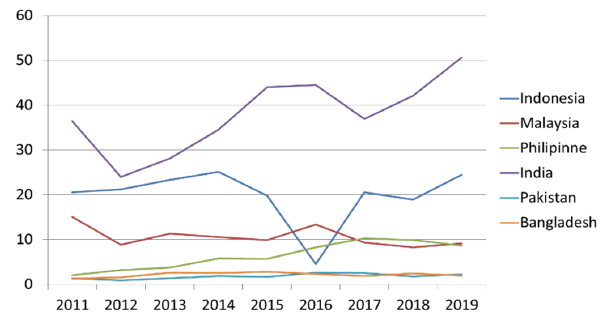
Fig. 6. Foreign direct investment net inflow of six Southeast and South Asian countries(Billion US$) Source: World Bank